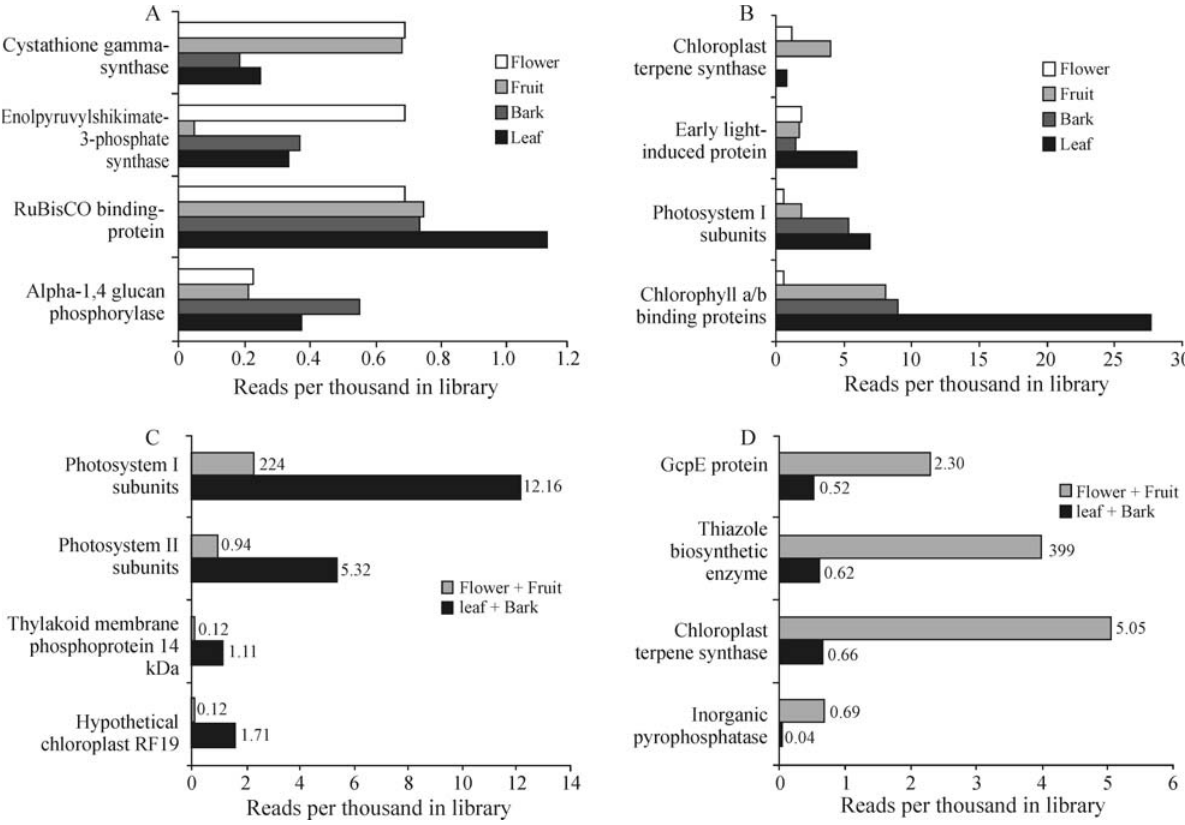
Figure1 -Preferentialexpressionof Citrussinensis sequencesinleaf,bark,fruitandflower-derivedcDNAlibrariesbasedonnormalizedfrequencies(A, B); and grouped into vegetative or reproductive organs (C, D). The sequences displayed significant differences in expression (p < 0.05) based on Audic and Claverie (1997), between vegetative and reproductive organs (C and